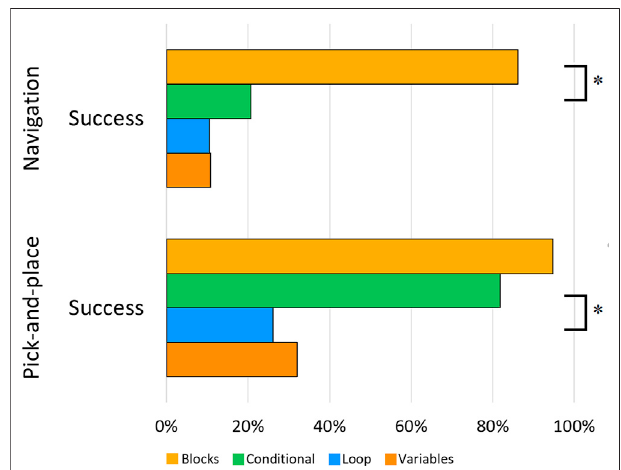
FIGURE 5 | Percentage of successfully completed programs per subtask per task. * indicates signi fi cant differences ( p < 0.016) (Recall that each task is only compared statistically to the task directly below it, for a total of three pairwise